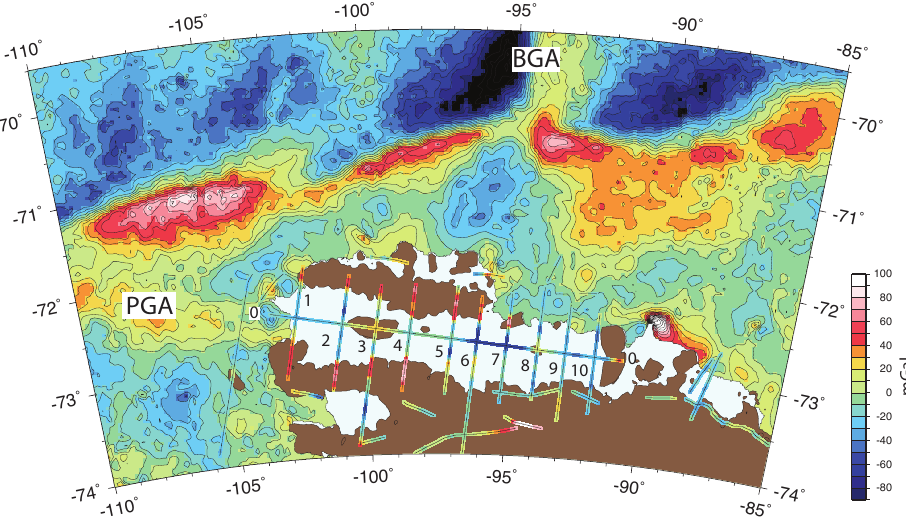
Fig. 2. Free-air gravity anomalies from Operation IceBridge flights over the Abbot Ice Shelf plotted along flight lines. Gravity anomalies in offshore areas are satellite-derived free-air anomalies from McAdoo and Laxon (1997) contoured at 10mGal intervals. Color scale for airborne and satellite gravity anomalies is shown on the right. Numbers identify profiles shown in Fig. 3 and discussed in the text. PGA, Peacock gravity anomaly; BGA, Bellingshausen gravity